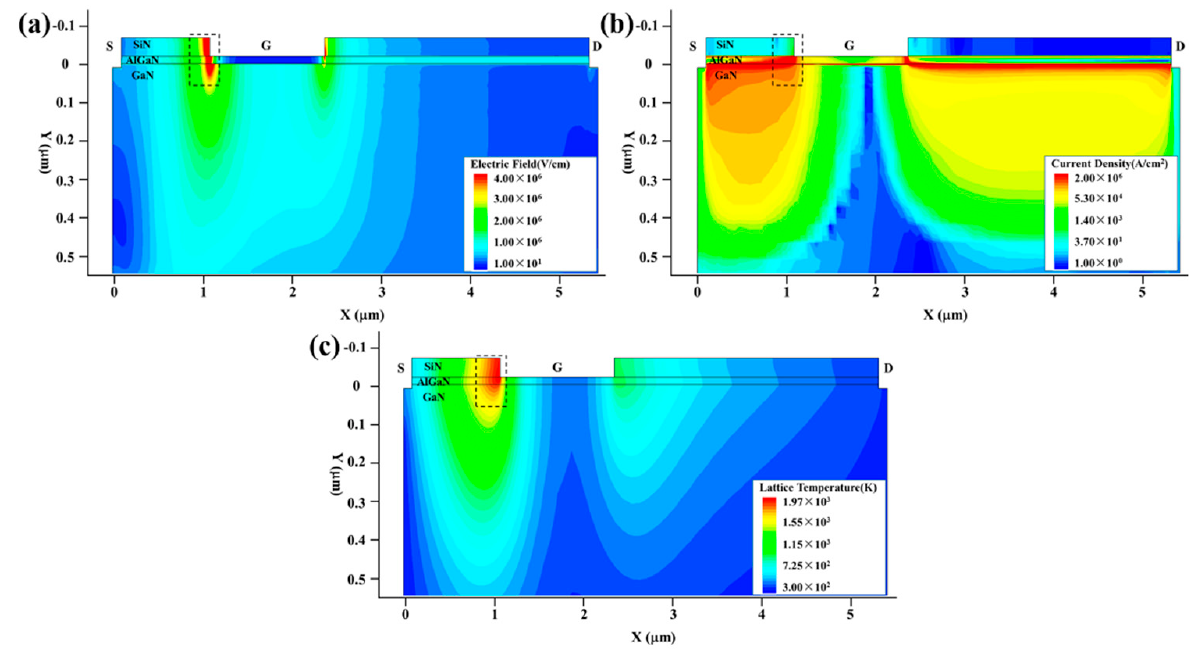
Figure 6. The internal ( a ) electric field intensity, ( b ) current density and ( c ) thermal distribution of the device at the moment of burnout.